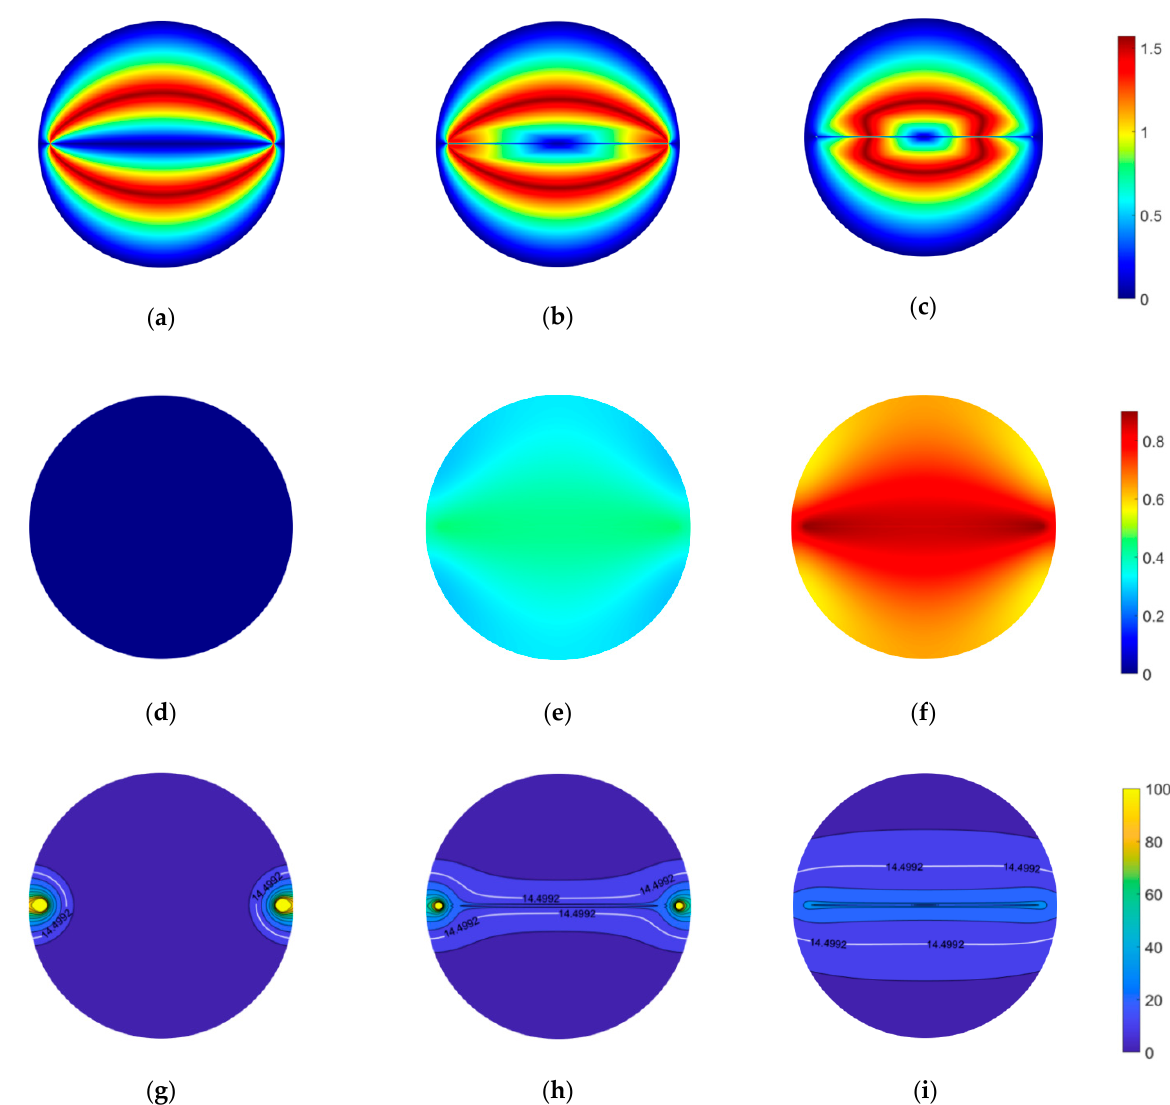
Figure 11. Time-averaged EI values over the domain for ( a – c ) streamline crossing and ( d – f ) relative rate of velocity change and ( g – i ) the contour of v sum with µ of 1.0 and ν of 0.9. From the left, each column represents r trans = 0.0, 0.5, and 1.0. The white line in the last row denotes v thresh , equal to 14.4992. Note, the colour bar range for mobility is fixed at 0 to 100 in order to highlight the region where v sum is greater than v thresh